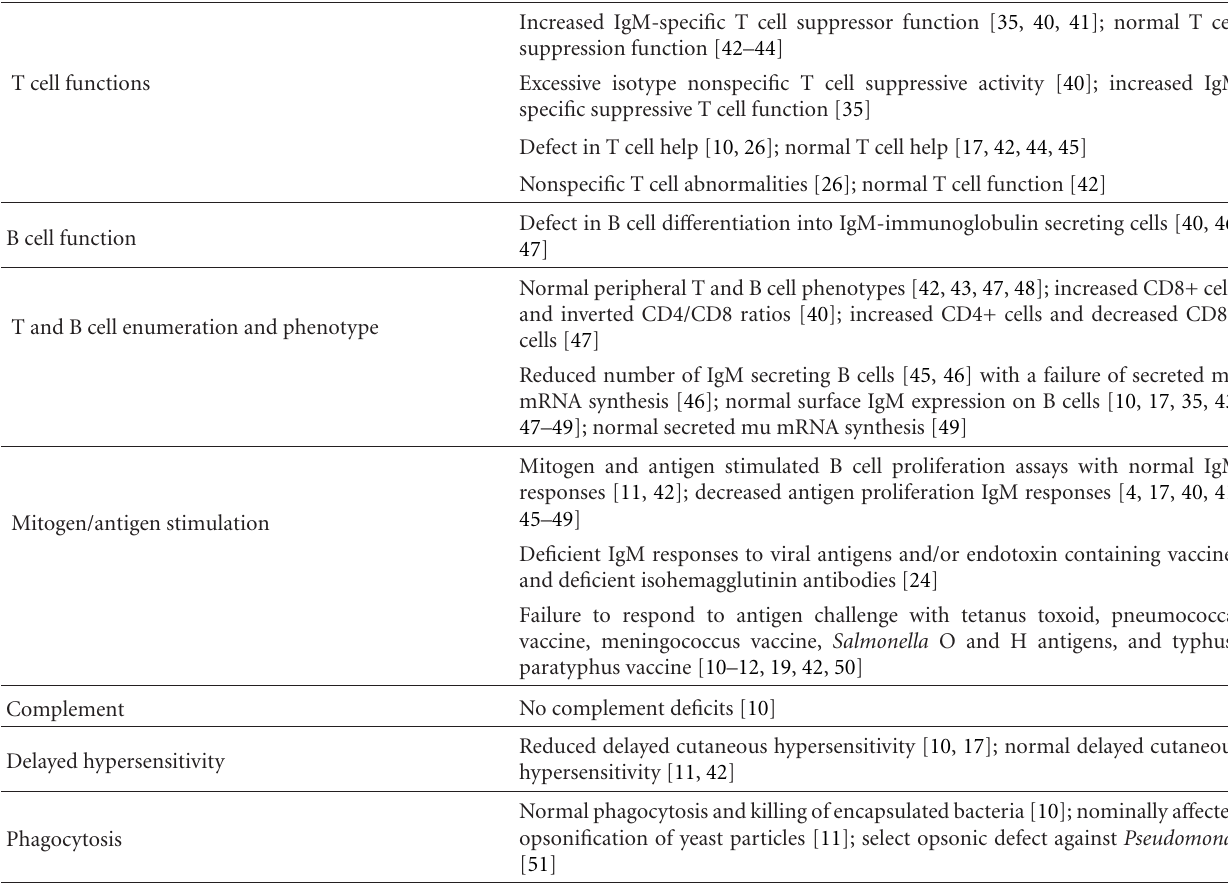
Table 3: Immunologic abnormalities in